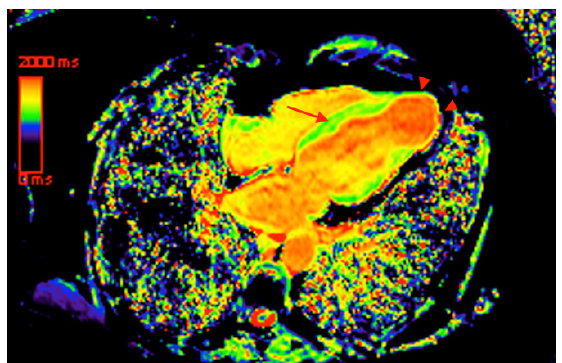
Figure 4. Four chamber image with color-coded native (non-contrast) T1 map, indicating the presence of mesocardial septal fibrosis (arrow) and apical transmural fibrosis (arrowheads). Increased native T1 is represented by yellow areas within the myocardium.